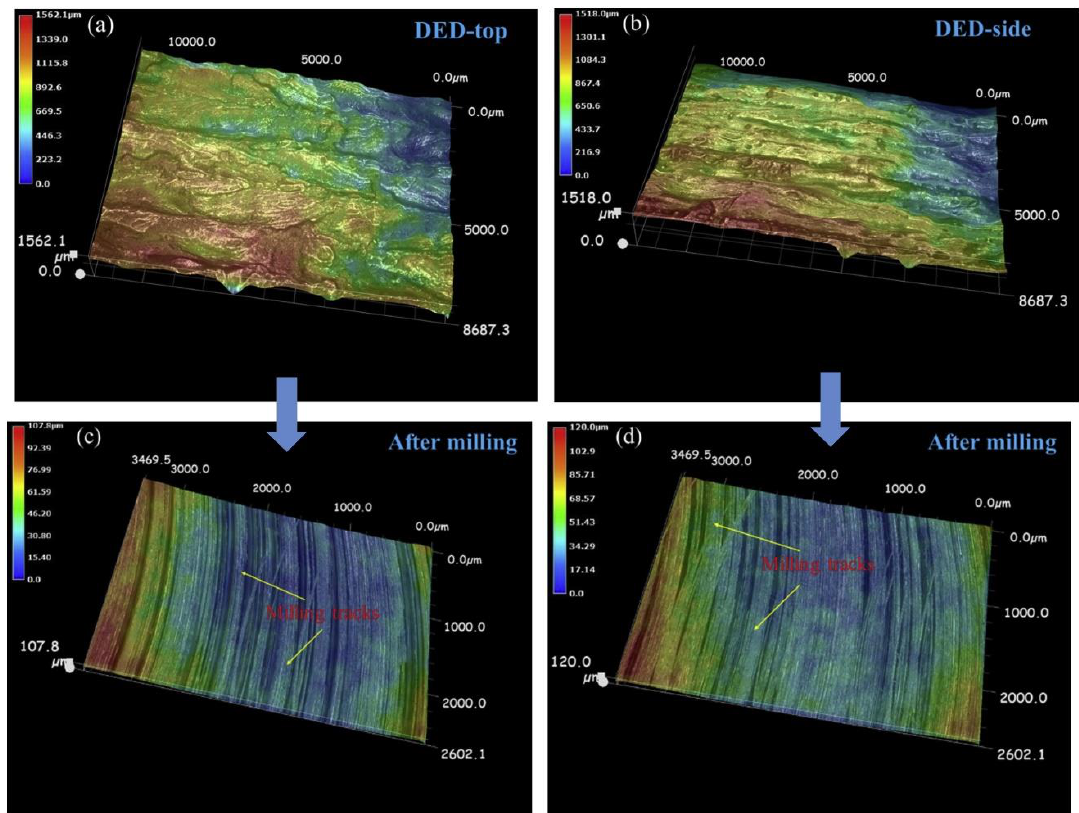
Figure 21. Surface morphology of AM samples (a) top surface before milling, (b) side surface before milling, (c) top surface after milling and (d) side surface after milling [92]; with permission from Elsevier.